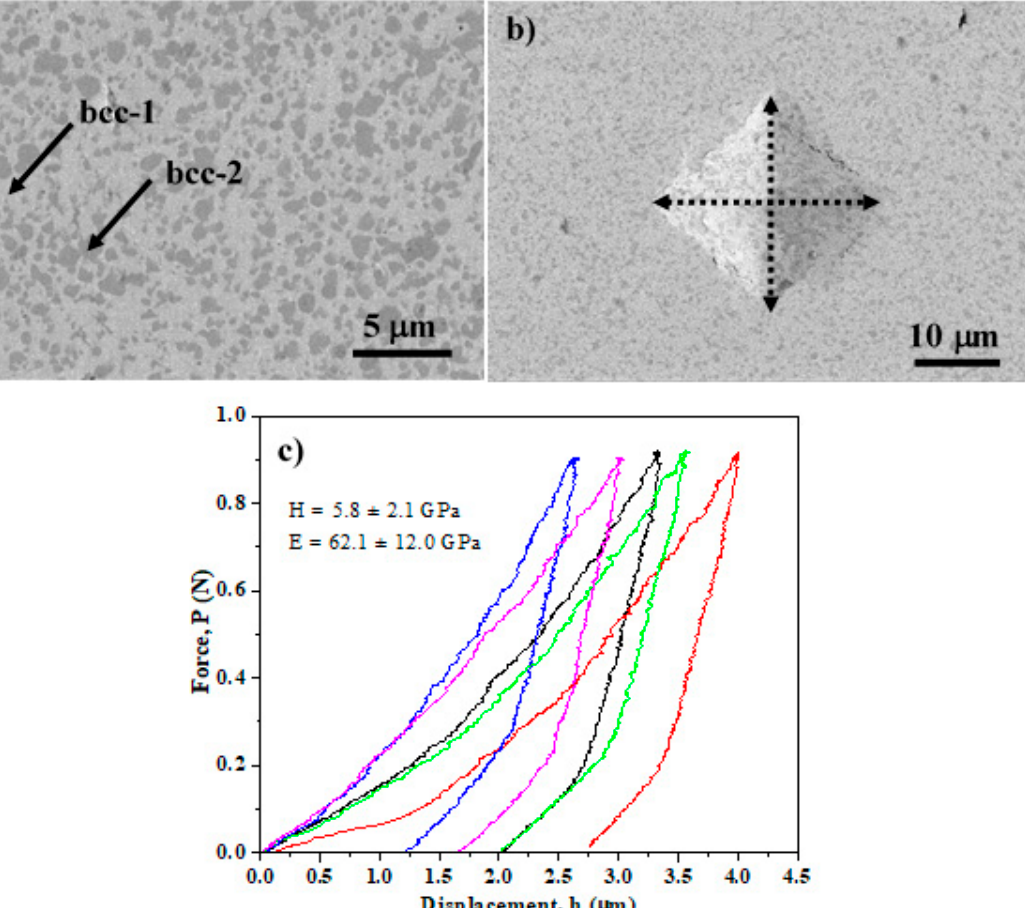
Figure 7. ( a ) SEM image, ( b ) indentation mark and ( c ) load–displacement (P–h) curve obtained from